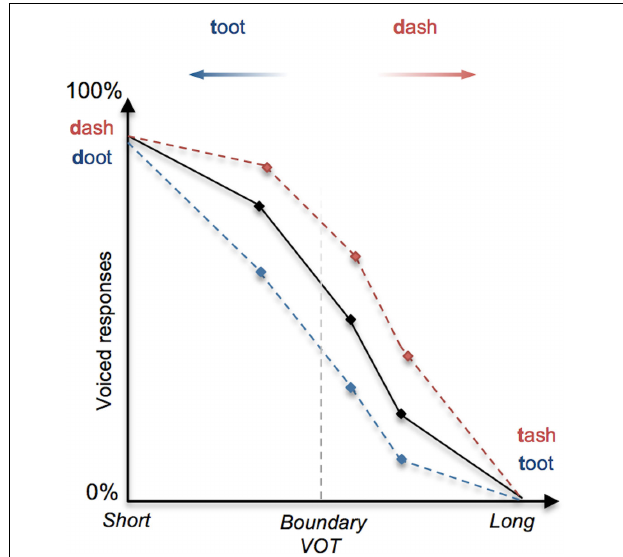
FIGURE 1 | Illustration of the lexical effect (adapted from Ganong, 1980). The perception of a stop consonant as voiced (e.g., [d]) or unvoiced (e.g., [t]) depends primarily upon the duration of the interval between the stop release “burst” and the onset of vocalization ( voice-onset time , or VOT), whereby a short VOT is perceived as voiced and a long VOT is perceived as unvoiced. When a continuum of stimuli is presented to subjects that involve stop consonants with systematically increasing VOT, the perception shifts from voiced ([d]) to unvoiced ([t]); shown as a decreasing tendency to identify stimuli as voiced. In this example of the lexical effect , the proportion of perceived voiced responses (represented on the y -axis) for a given VOT stimulus tends to increase (red dashed line) or decrease (blue dashed line) as a function of whether the stimuli correspond to real words (e.g., “dash” and “toot”) or pseudo-words (e.g., “tash” and “doot”).